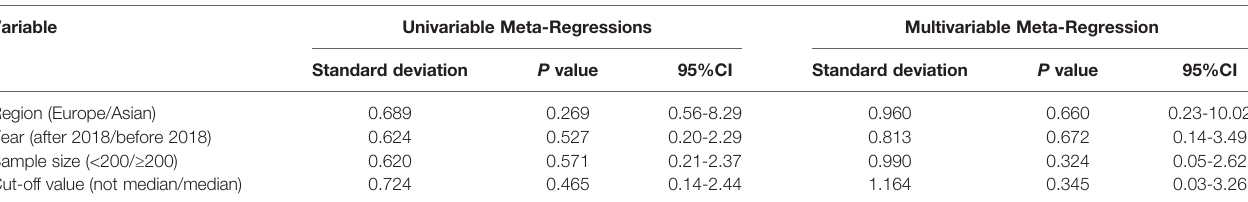
TABLE 4 | Univariable and multivariable meta-regressions for